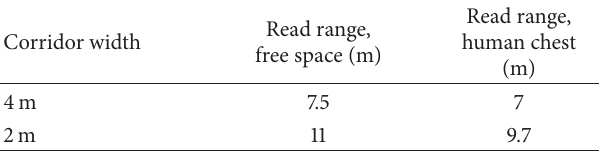
Table 3: Identification tests of the folded coupled patches antenna in free space as well as on the human chest in buildings